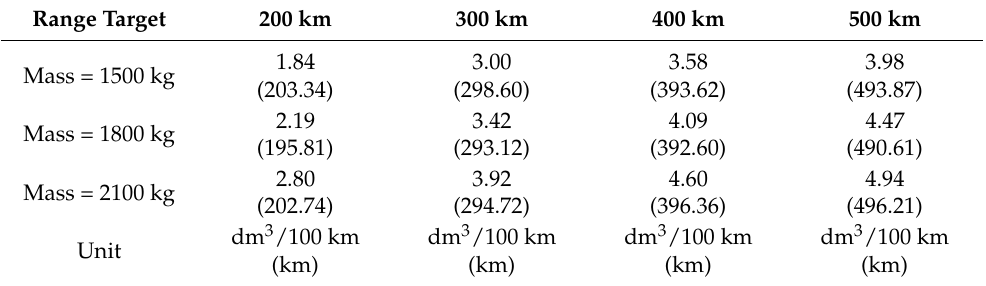
Table A7. Fuel consumption in EREV mode for WLTC 3b High 3-2.